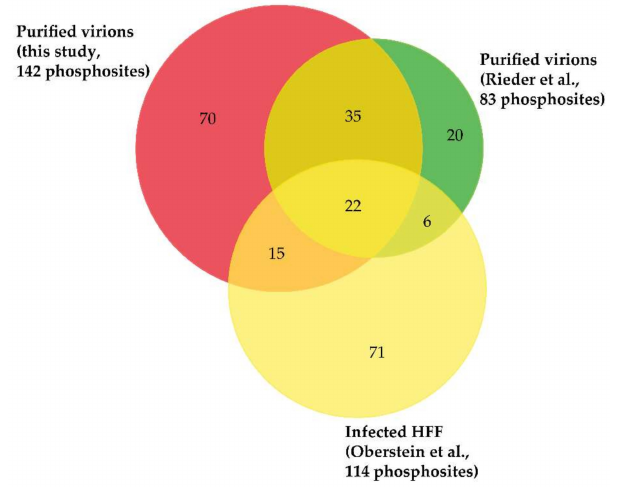
Figure 3. Venn diagram displaying overlap of phosphosites identified on viral proteins in HCMV virions (Rieder et al. [23] and this study) and in infected cells (Oberstein et al. [25]). Importantly, only phosphosites identified with localization probabilities above 75% were taken into